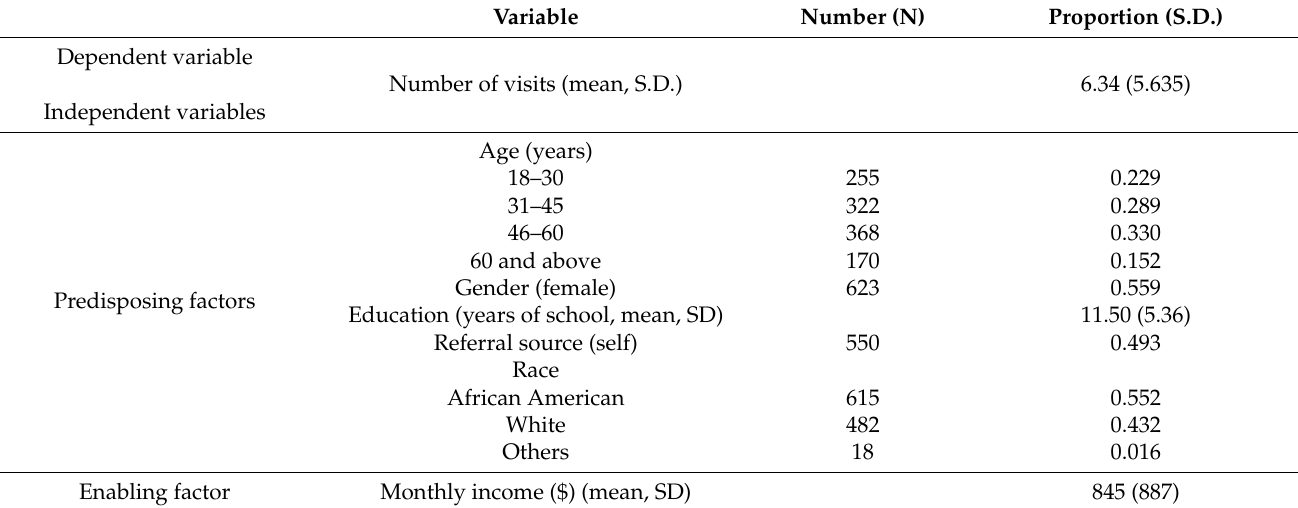
Table 2. Characteristics of the sample (N = 1115). Variable